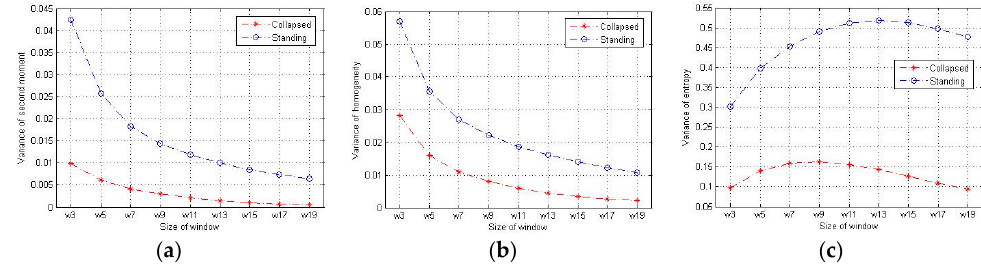
Figure 12. Evolution of the variation coefficient in relation to different window sizes for textural measures of the ( a ) second moment, ( b ) homogeneity and ( c ) entropy.